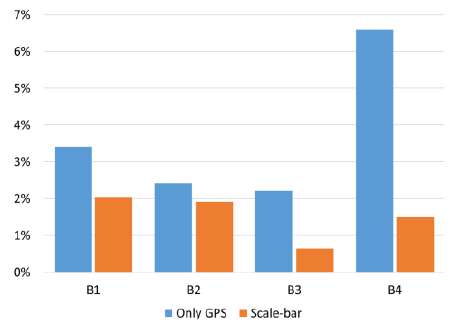
Figure 10 . Representation of relative scale errors, with scale obtained by GPS only, and after the scale bar